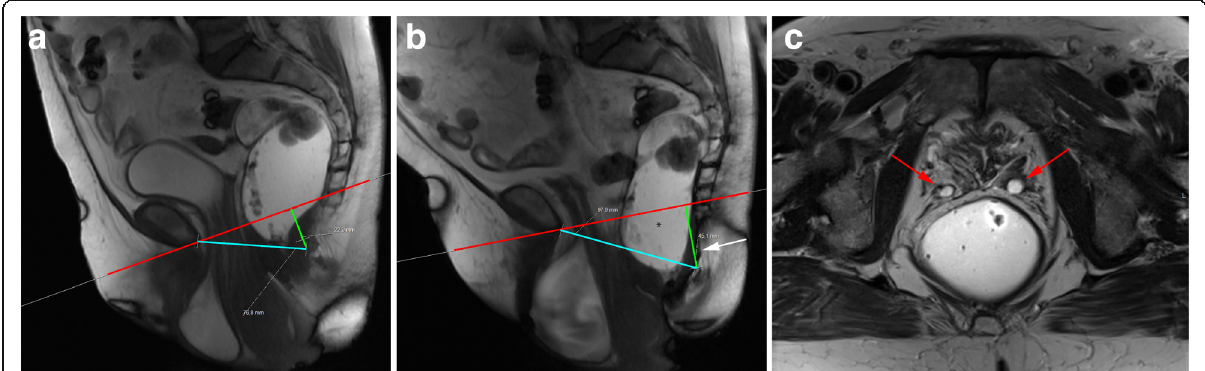
Fig. 18 Descending perineal syndrome with tricompartimental prolapse. ( a , b ) Sagittal midline TruFISP images at rest ( a ) and during evacuation ( b ). H line (blue line) measures 7.7 cm ( a ) and 9.8 cm ( b ) and the M line (green line) measures 2.3 cm ( a ) and 4.5 cm ( b ), demonstrating widening and descent of the levator hiatus, even at rest but aggravating during defecation. It is also associated with tricompartimental prolapse, with a severe cystocele and a severe uterine everted prolapse. Note the verticalization of the levator plate (white arrow). Another interesting finding is that the rectal contrast is only partially expelled ( b ), because the mass effect by both the cystocele and uterine prolapse induces mechanical posterior obstruction (dilated rectum filled with ultrasound gel) causing constipation and incomplete evacuation (*). ( c ) Axial T2-TSE image at the pubic symphysis plane showing bilateral ureterohydronephosis causes by the cystocele (red